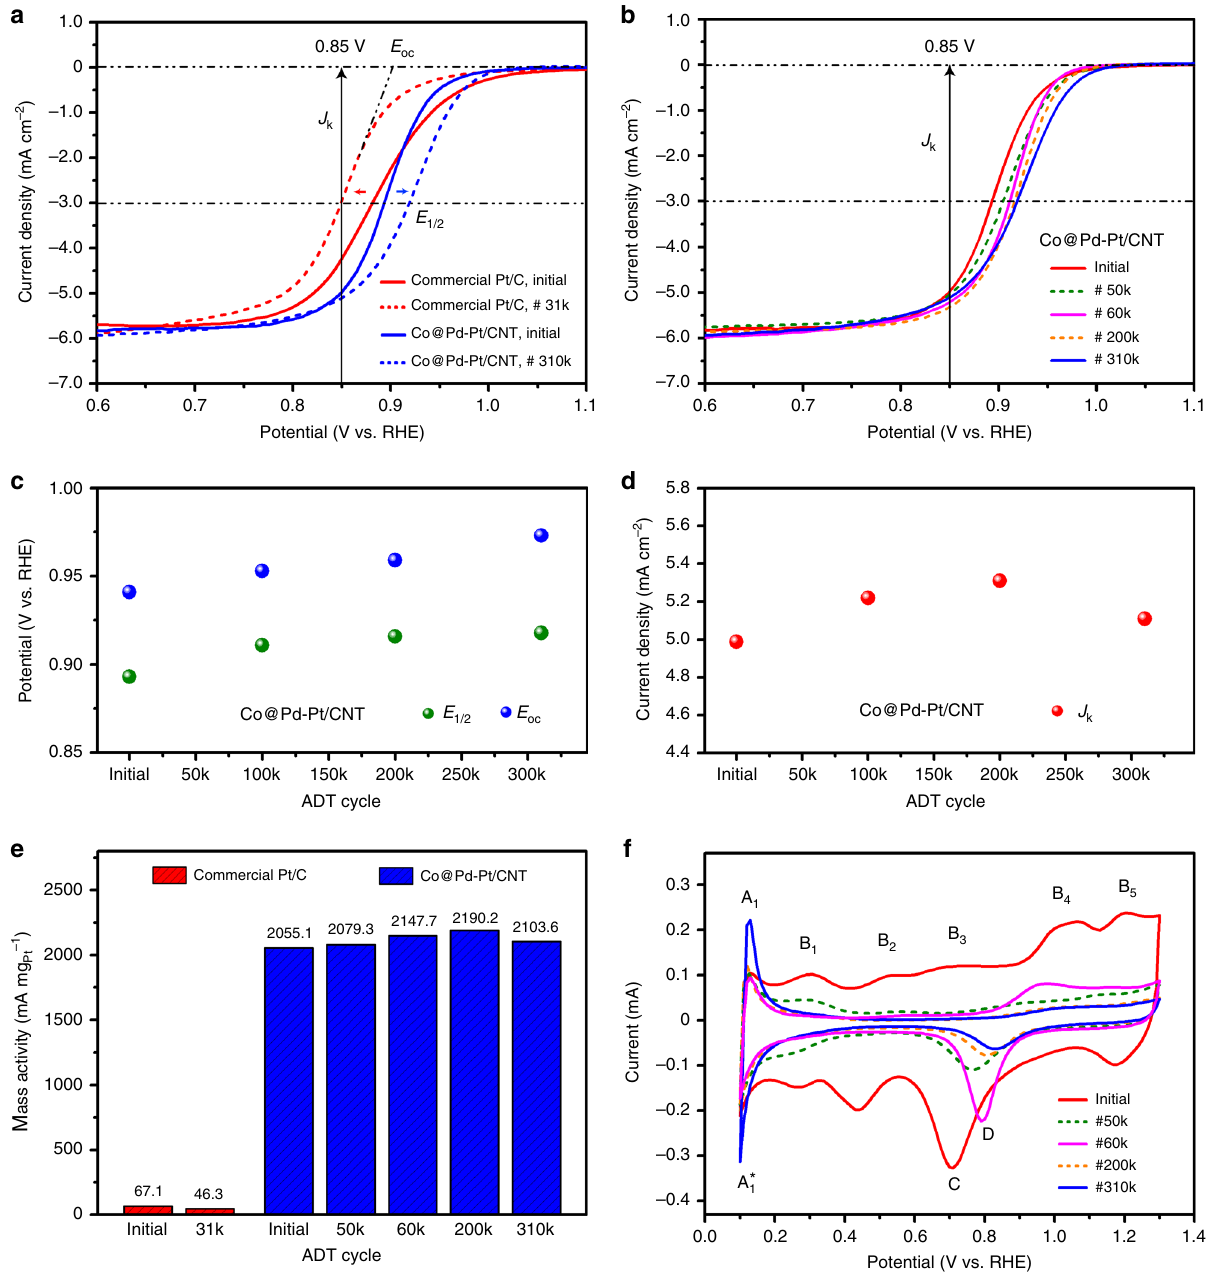
Fig. 4 Electrochemical results of Pt-decorated Co-Pd nanocatalyst. a Initial and fi nal oxygen reduction reaction (ORR) polarization curves of commercial Pt/ C and Pt-decorated Co-Pd (Co@Pd-Pt/carbon nanotube (CNT)) catalysts. b ORR polarization curves of Co@Pd-Pt/CNT at selected accelerated degradation test (ADT) cycles. c Changes of onset potential and half-wave potential of Co@Pd-Pt/CNT at selective ADT cycles. d Changes of kinetic current density of Co@Pd-Pt/CNT at selective ADT cycles. e Comparison of ORR mass activity of commercial Pt/C and Co@Pd-Pt/CNT at selected ADT cycles. f Cyclic voltammetry (CV) curves of Co@Pd-Pt/CNT at selected ADT